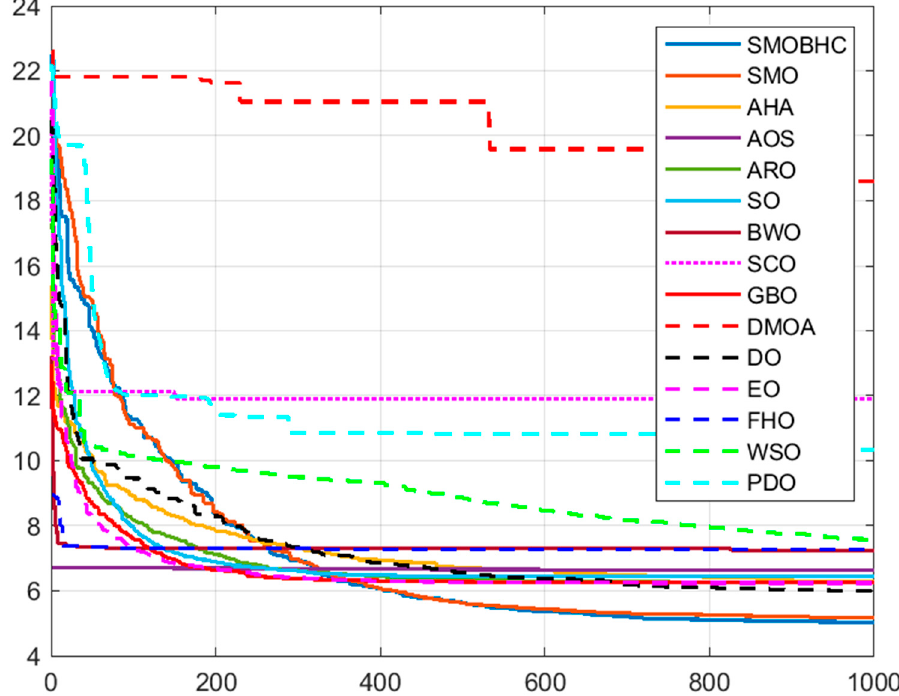
Figure 20. Comparative convergence curves of algorithms for battlefield 3 with 𝐷 = 90 .